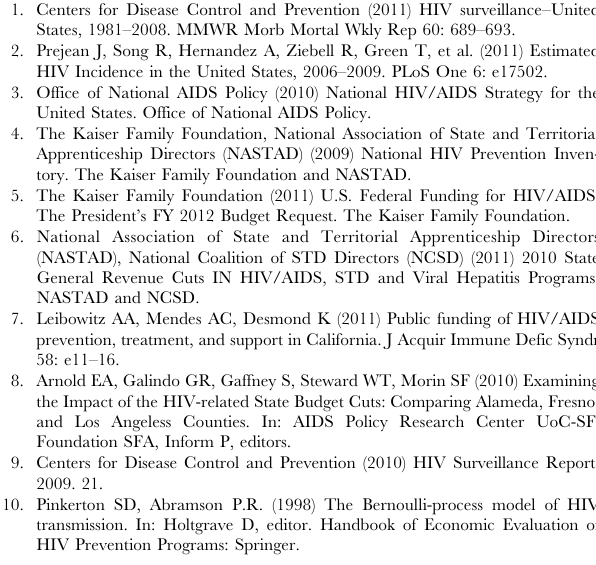
Table S1 Baseline value, range, and distribution of input parameters for multivariate sensitivity